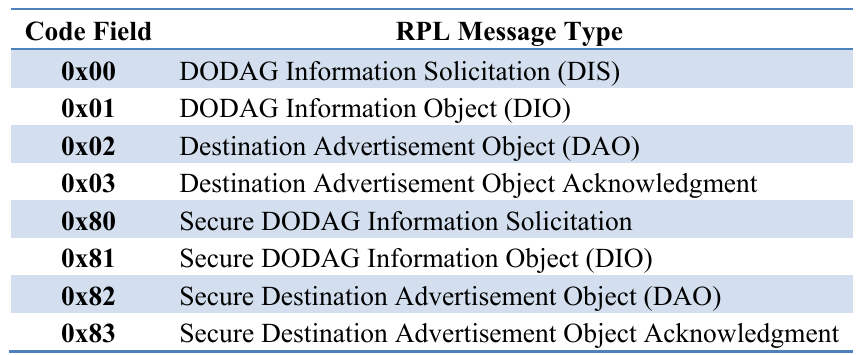
Table 4. Code fields in RPL ICMPv6 messages.